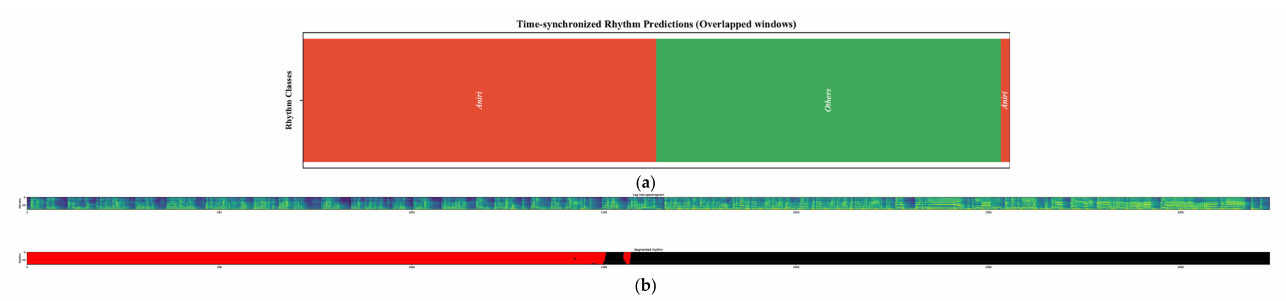
Figure 6. Classification-based and semantic segmentation-based Pansori rhythm segmentation on same test sample. The color indicates the rhythmic class as in Figure 5. ( a ) Segmented output on test sample using classification-based segmentation method (ground truth: Aniri 0 to 50 s and Hweemori 51 to 101 s). The segmented classes are distinguished by color and captions. ( b ) Segmented rhythm in a test sample using DeepLabV3+. The upper figure is an input log Mel-spectrogram and the lower figure is the predicted mask (ground truth: Aniri 0 to 50 s and Hweemori 51 to 101